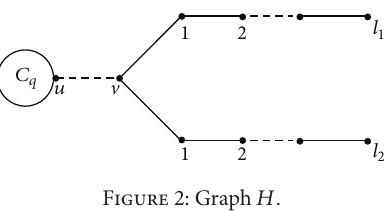
Figure 2: Graph 𝐻